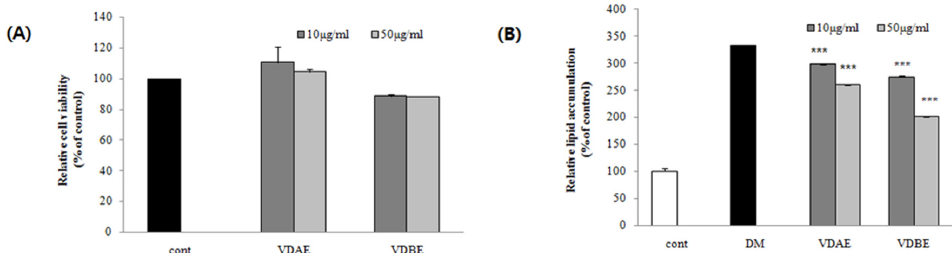
Figure 1. Effects of Valeriana dageletiana Nakai ex F. Maek. extracts in 3T3-L1. ( A ) Effect of VDAE and